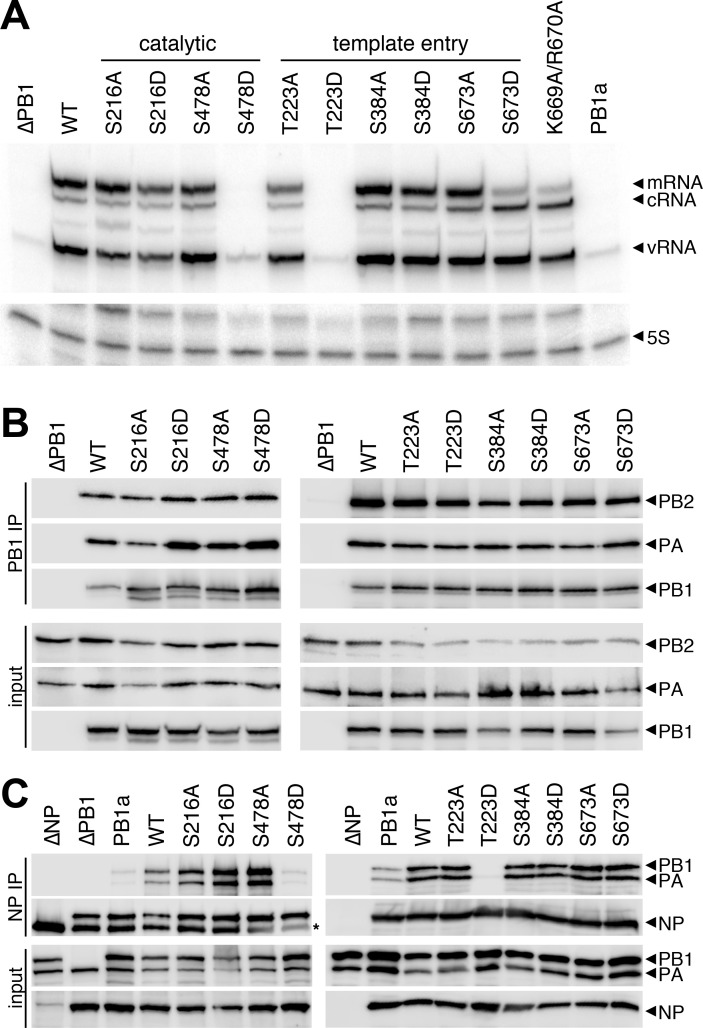
PB1 phospho-mutants are defective in RNA synthesis and RNP formation.A. Viral RNA synthesis was analyzed in primer extensions assays. RNA extracted from 293T cells expressing the viral polymerase, NP, and segment 6 vRNA was subject to primer extension analysis to detect transcription (mRNA) and replication (cRNA, vRNA) products. Primer extension of 5S rRNA was used as an internal loading control. PB1a, catalytically-dead PB1; PB1 K669A/R670A, transcription-deficient PB1. B. PB1 phospho-mutants form polymerase trimers. FLAG-tagged PB1, PB2, and PA were expressed in 293T cells and cell lysates were subject to PB1-FLAG immunoprecipitation. Immunoprecipitates and input samples were probed for PB1-FLAG, PB2, and PA. C. PB1 phospho-mimetics deficient in RNA synthesis fail to generate productive RNPs. NP immunoprecipitations were performed on 293T lysates generated as in (A). Immunoprecipitates and input samples were western blotted for PB1, PA, and NP.